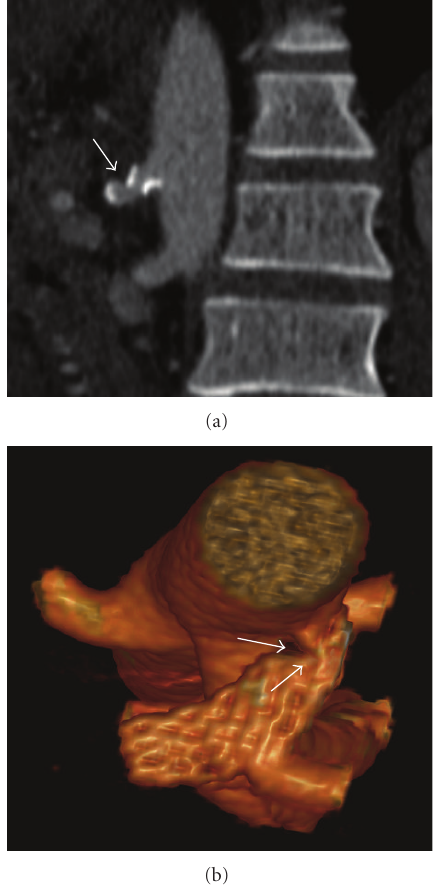
Figure 5: Sagittal view (a) and 3D reconstruction (b) of the CTA at 15-month follow up show stent patency and focal residual stenosis (arrows) at proximal celiac